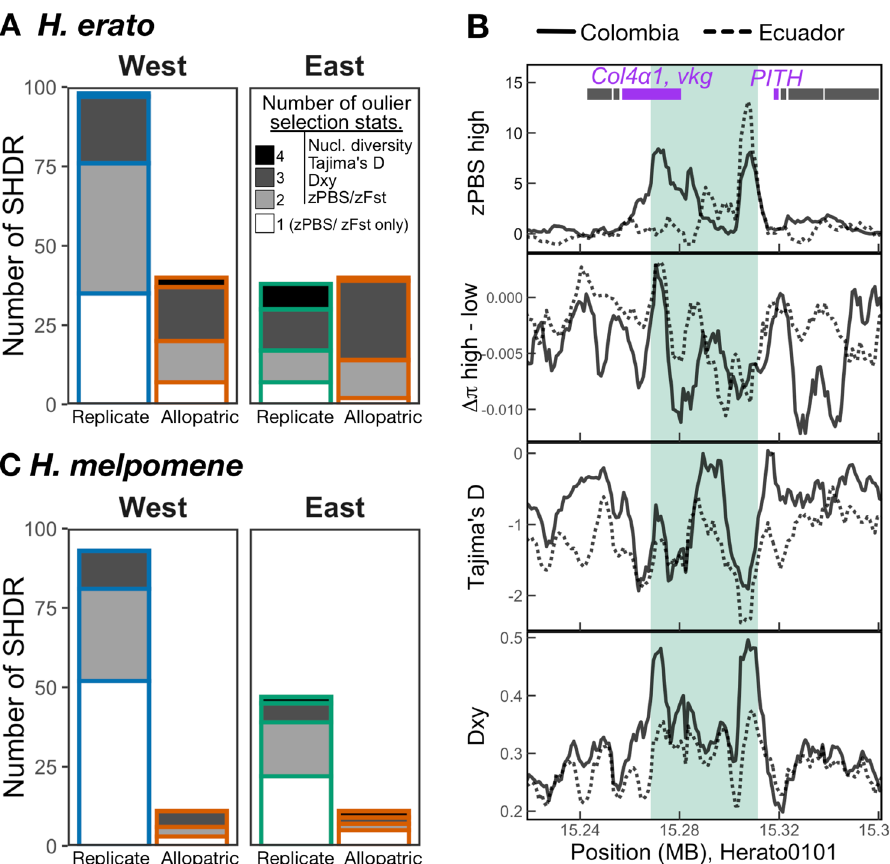
Fig. 4 | Signatures of positive selection across shared high differentiation regions (SHDRs). Numberof SHDRwith additionaloutlierselection statisticsin H. erato ( A ) and H. melpomene ( C ), statistics included were nucleotide diversity dif- ference between highlands and lowlands ( Δπ ), Tajima ’ s D, and absolute genetic differentiation (Dxy). Bars are coloured according to whether they are shared between replicate transects within sides of the Andes (blue or green) or across all transects(allopatric,inred).Shadingindicatesnumberofstatisticsthatwereabove